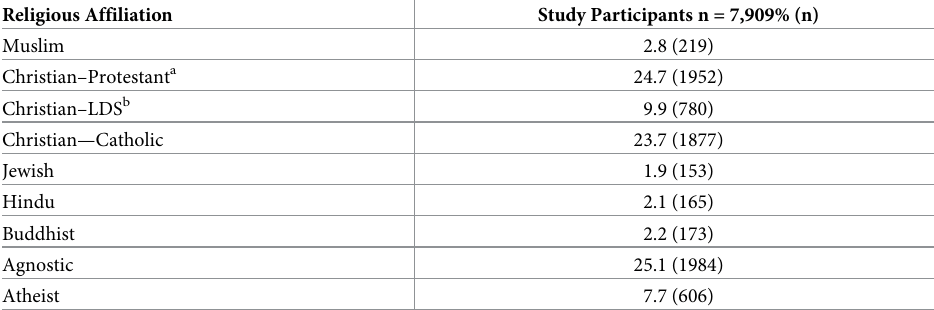
Table 1. The religious affiliations of undergraduate biology students in this study. Religious